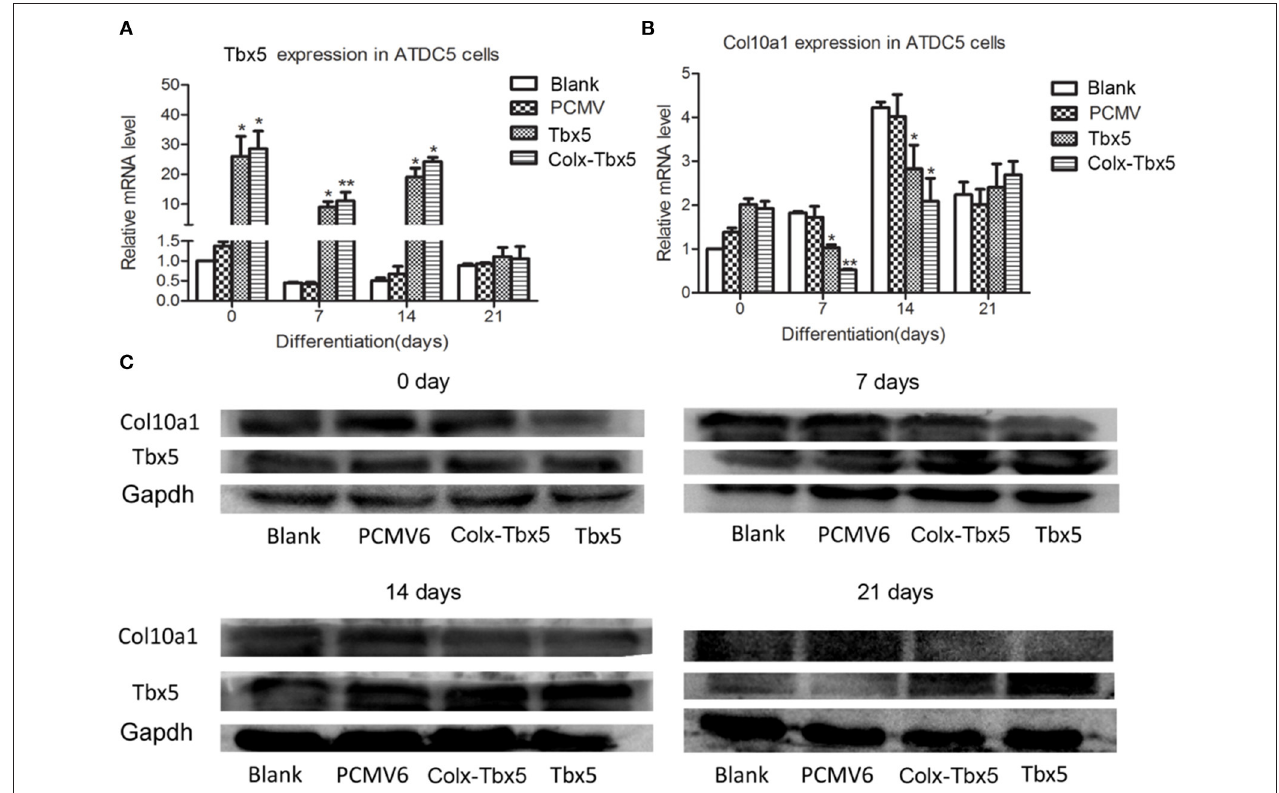
FIGURE 5 | Tbx5 overexpression inhibited Col10a1 expression in ATDC5 cells. (A) Tbx5 mRNA was upregulated in ATDC5 cells stably transfected with Tbx5 expression plasmid compared with vector and blank controls. (B) Col10a1 expression was inhibited in Tbx5 -overexpressing cells compared with vector and blank controls. (C) Protein levels of Tbx5 and Col10a1 were similar to their mRNA levels. * p < 0.05, ** p <